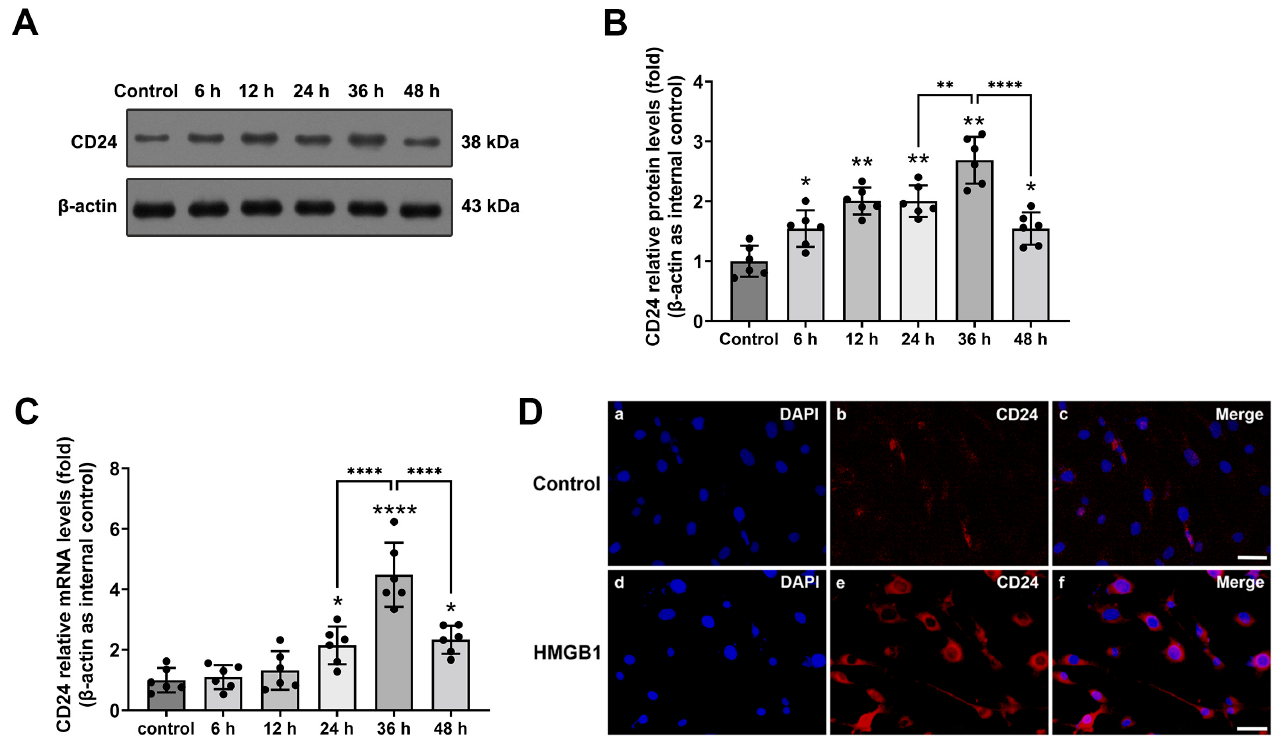
Figure 1. Expression and distribution of CD24 in cultured astrocytes after rHMGB1 stimulated. ( A ) Protein expression of CD24 in astrocytes using β -actin as loading control. Lane 1, control; lane 2, 3, 4, 5, and 6, the 6 h, 12 h, 24 h, 36 h, and 48 h groups, respectively; ( B ) Graphic representations of the ratios of CD24/ β -actin protein. Bars represent the mean ± SD ( n = 6, each group); ( C ) The mRNA expression of CD24 in cultured astrocytes measured by quantitative real-time PCR. Bars represent the mean ± SD ( n = 6, each group). * p < 0.05, ** p < 0.01, **** p < 0.0001 vs. control or indicated groups; ( D ) Immunofluorescence staining for CD24 in cultured astrocytes. ( a – c ) CD24 expression in the control group (DAPI = blue, CD24 = red); ( d – f ) CD24 expression in the rHMGB1 group at 36 h (DAPI = blue, CD24 = red). Bar = 50 µ m. Statistical comparison was conducted using one-way ANOVA; p < 0.05 was considered statistically significant.